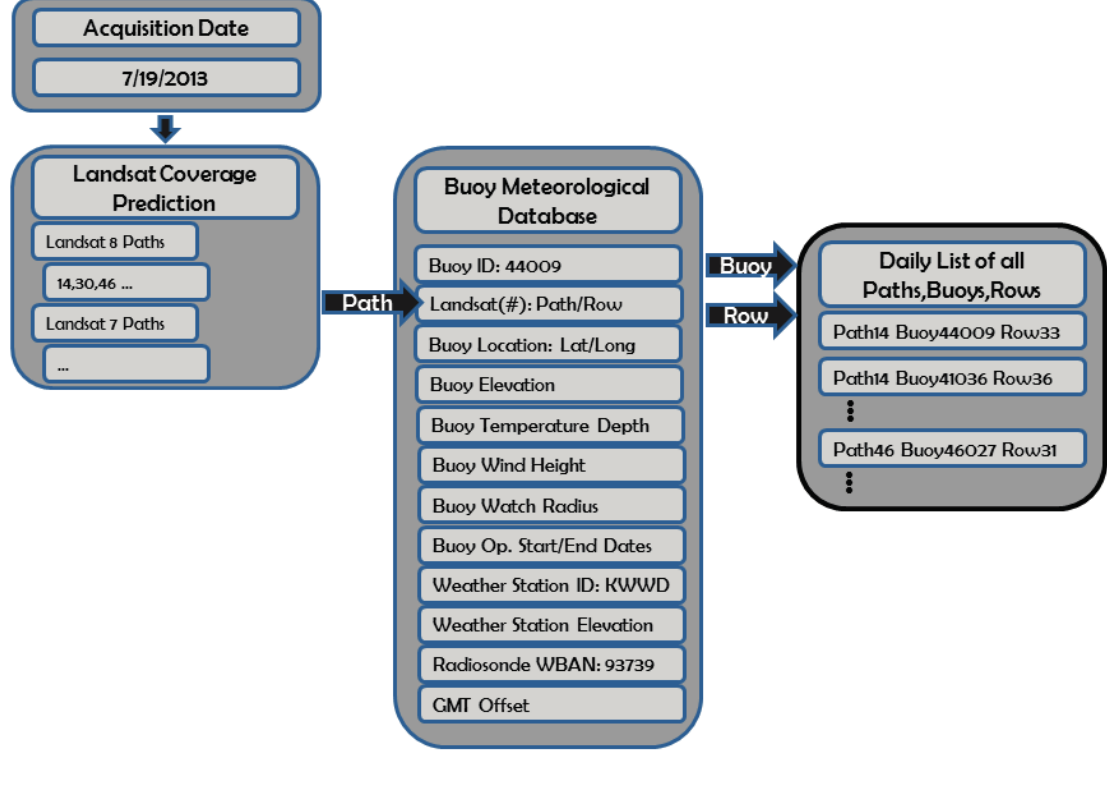
Figure 4. Selection of specific Landsat scenes and corresponding buoys for a given date using the buoy meteorological